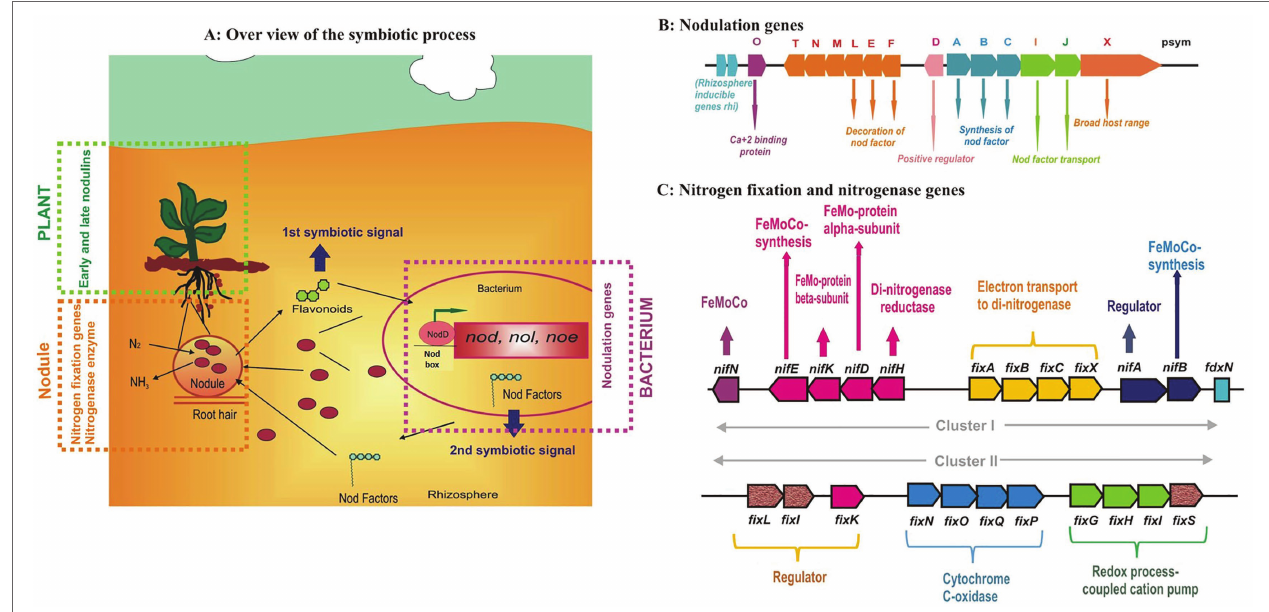
FIGURE 3 | The overall process of Rhizobium -legume symbiosis showing the locks and keys of the symbiotic specificity of (A) nodulation genes (B) and details of nitrogen fixation genes (C) present in the rhizobia (figures drawn from the available literature from different